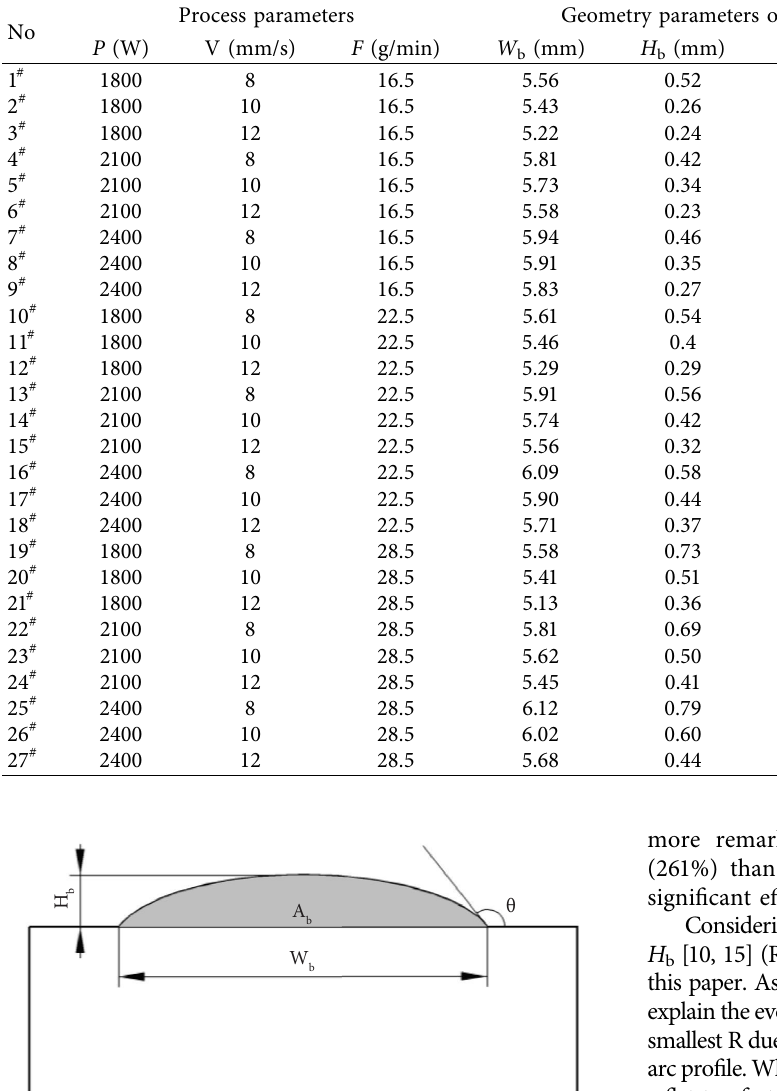
s ) of all the 27 clad tracks at diferent process